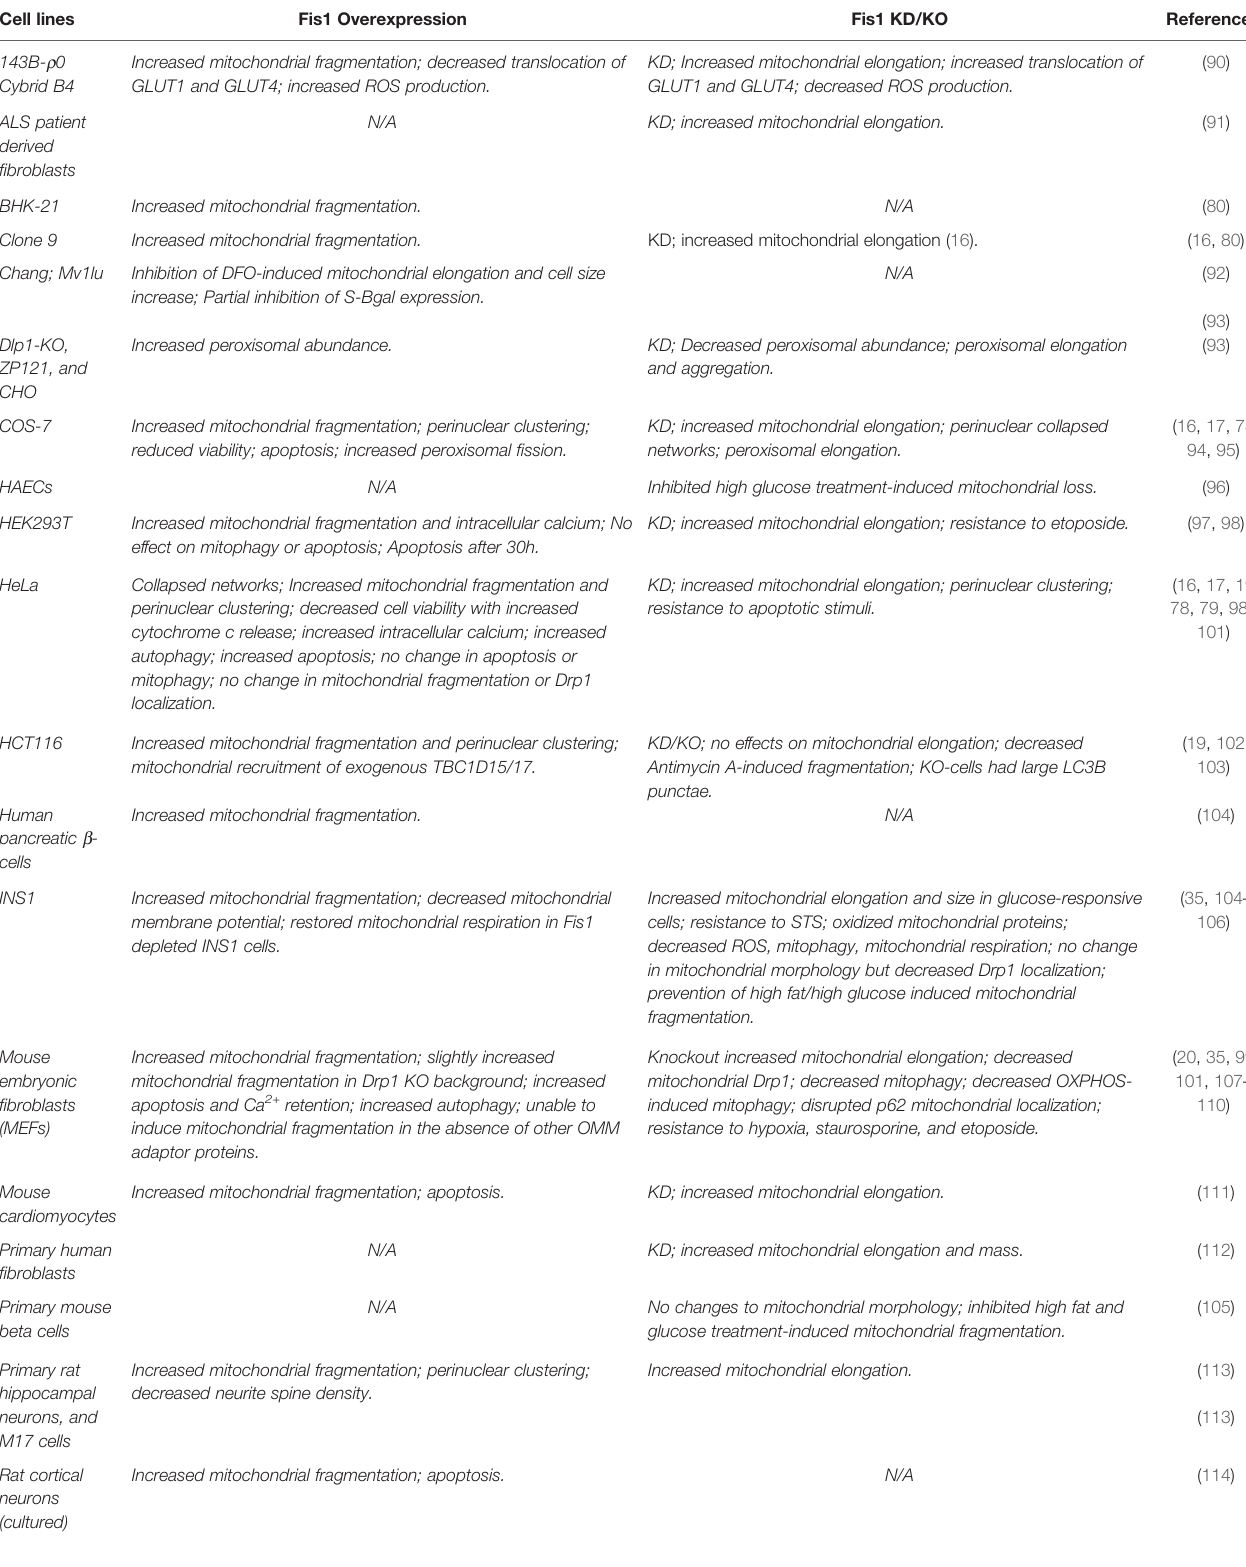
TABLE 1 | The effects of Fis1 overexpression or knock-out/down on mitochondrial morphology. Cell